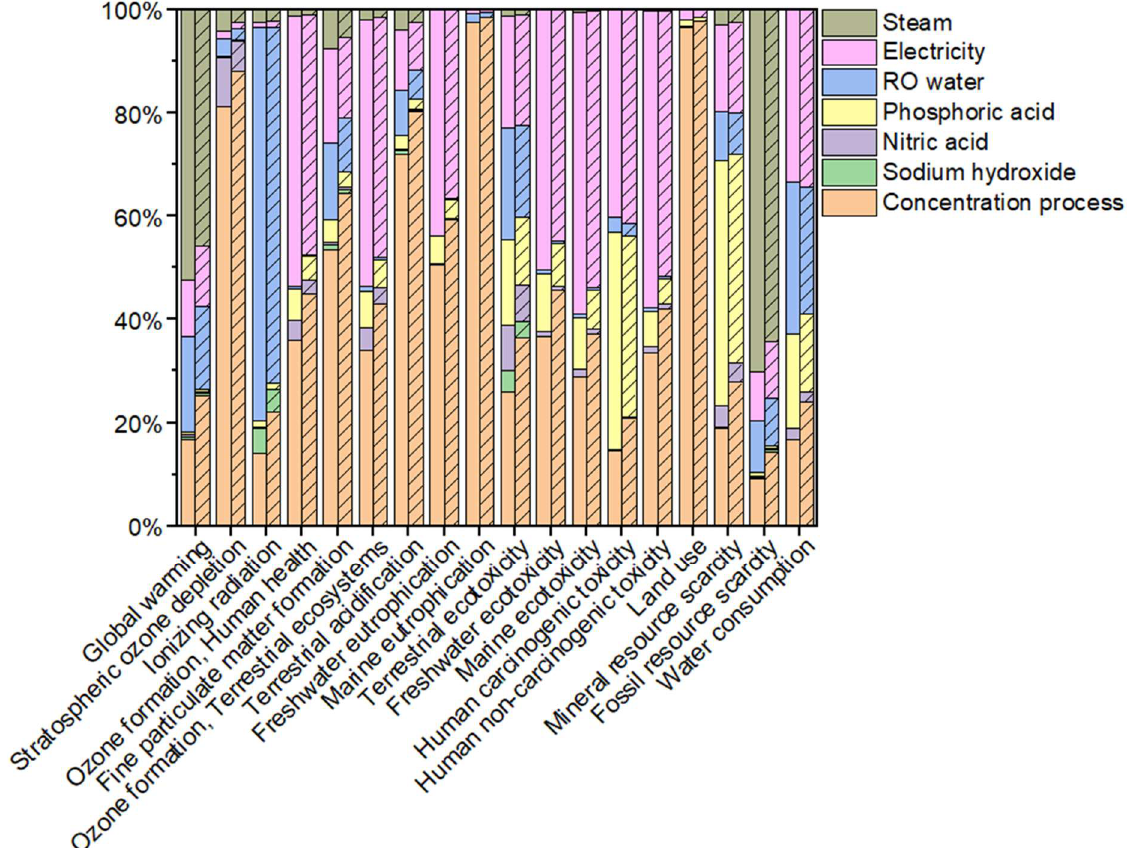
Figure 4. Contributions of concentration and CIP processes to total environmental impacts of simplified concentrated milk production. The CIP process is broken down into sodium hydroxide, nitric acid, phosphoric acid, water, electricity, and steam. Control (empty) and MB-assisted (patterned) CIP are compared.